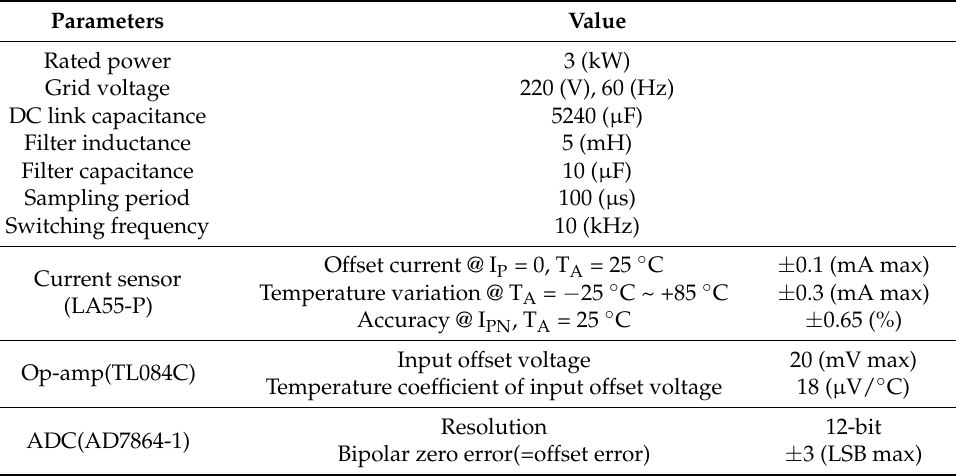
Table 1. Single-Phase Grid-tied Inverter Specifications.